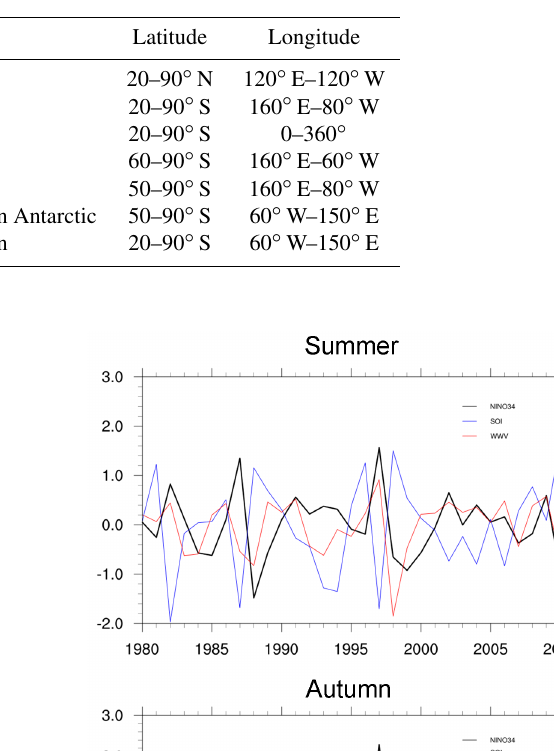
Table 1. Acronyms and specifications of the regions used to build the extratropical predictors.